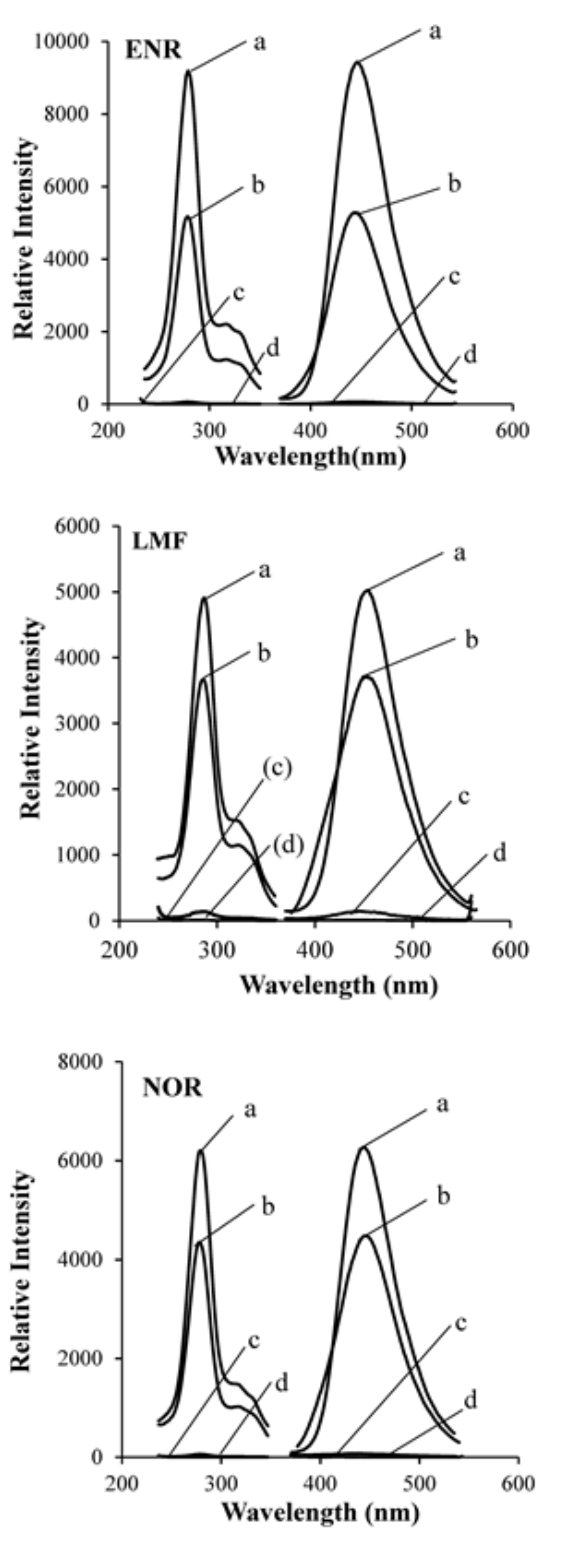
Figure 2: Fluorescence excitation and emission spectra of each FQ mixed with AgNPs (a) and in water (b), (c): water, (d): AgNPs